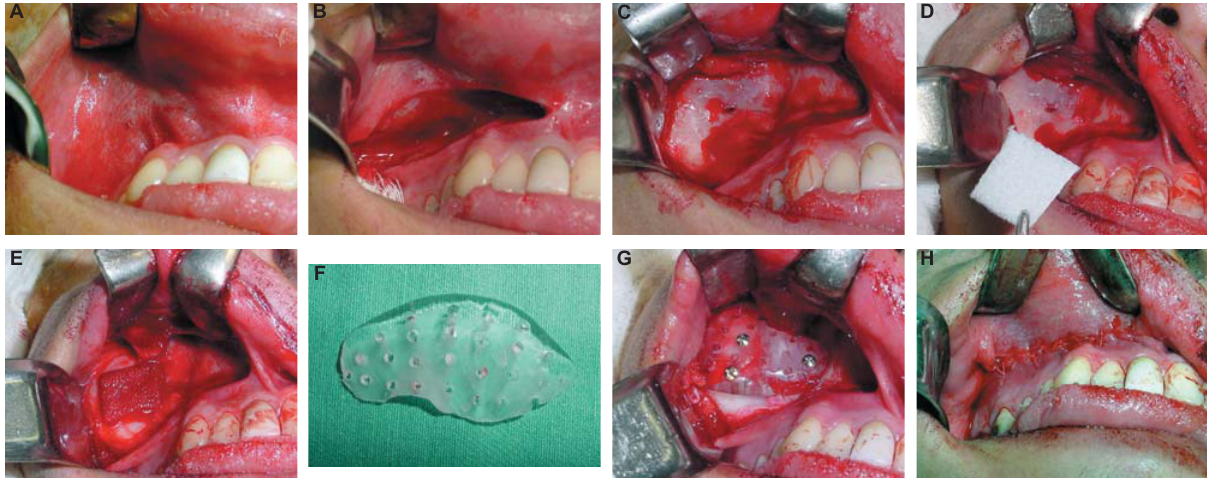
Figure 4- Panel of intraoperative photographs. A: Access to the zygomatic area. B-C: Incision in the superior left labial vestibule. D-E: Fibrin sponge placed in this area. F: Prosthesis recontoured by trimming it with an acrylic bur. G: Prosthesis A B C